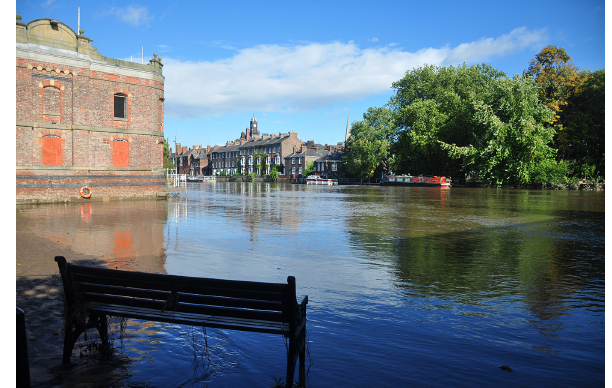
Fig. 3. Recent flood events at York (2012, Photo courtesy of Y. Di- dem